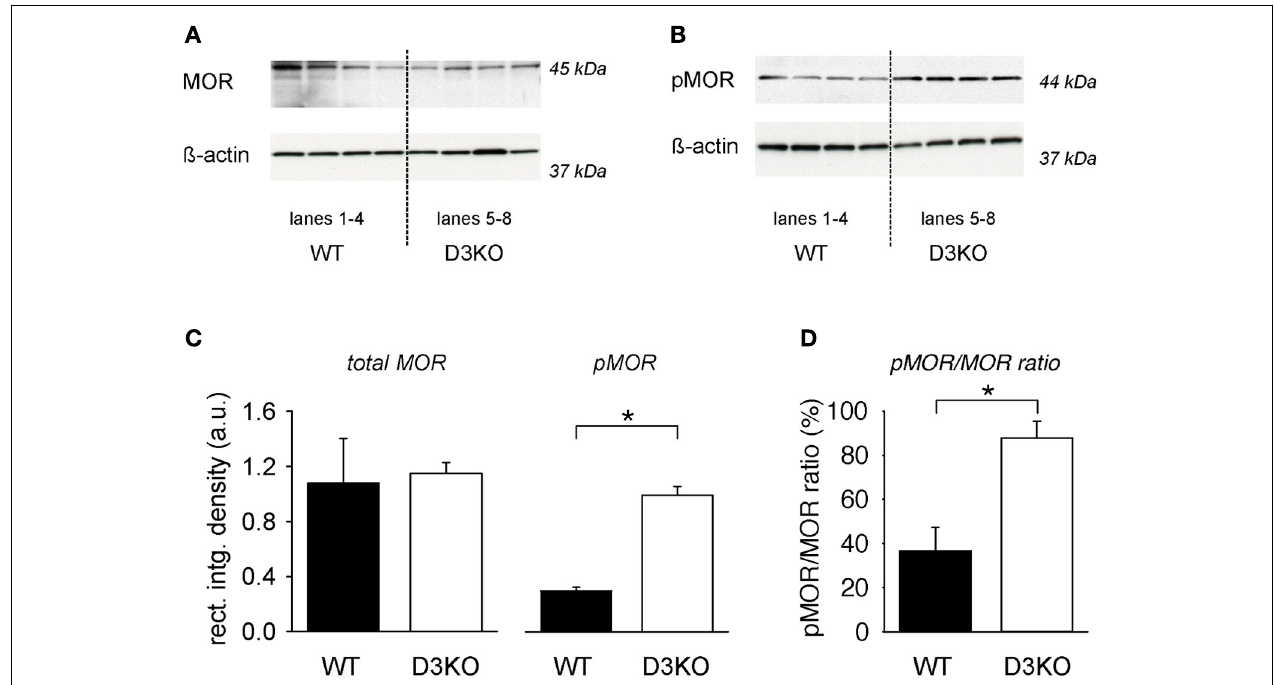
FIGURE 2 | Protein expression levels of total MOR and pMOR in lumbar spinal cord, normalized to β -actin. (A) Total MOR protein expression in WT and D3KO (top panels), and their respective ß-actin protein expressions (bottom panels). Lanes 1–4 represent lumbar spinal cords from four independent WT, while lanes 5–8 represent tissues from four independent D3KO. Total MOR protein expression levels were overall similar between WT and D3KO. Note that we first probed for MOR expression before stripping and re-probing for ß-actin. (B) pMOR protein expression levels in WT and D3KO (top lanes), and their respective ß-actin protein expression (bottom